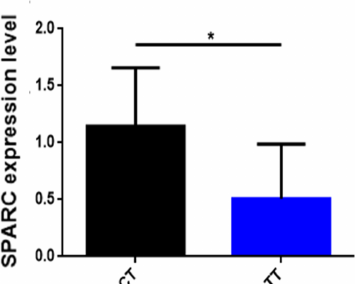
Figure 4. The correlation of SNP with the mRNA expression in SPARC gene. Note that three independent experiments were re- peated for reliability. An asterisk denotes a significant difference by t test ( P < 0 .